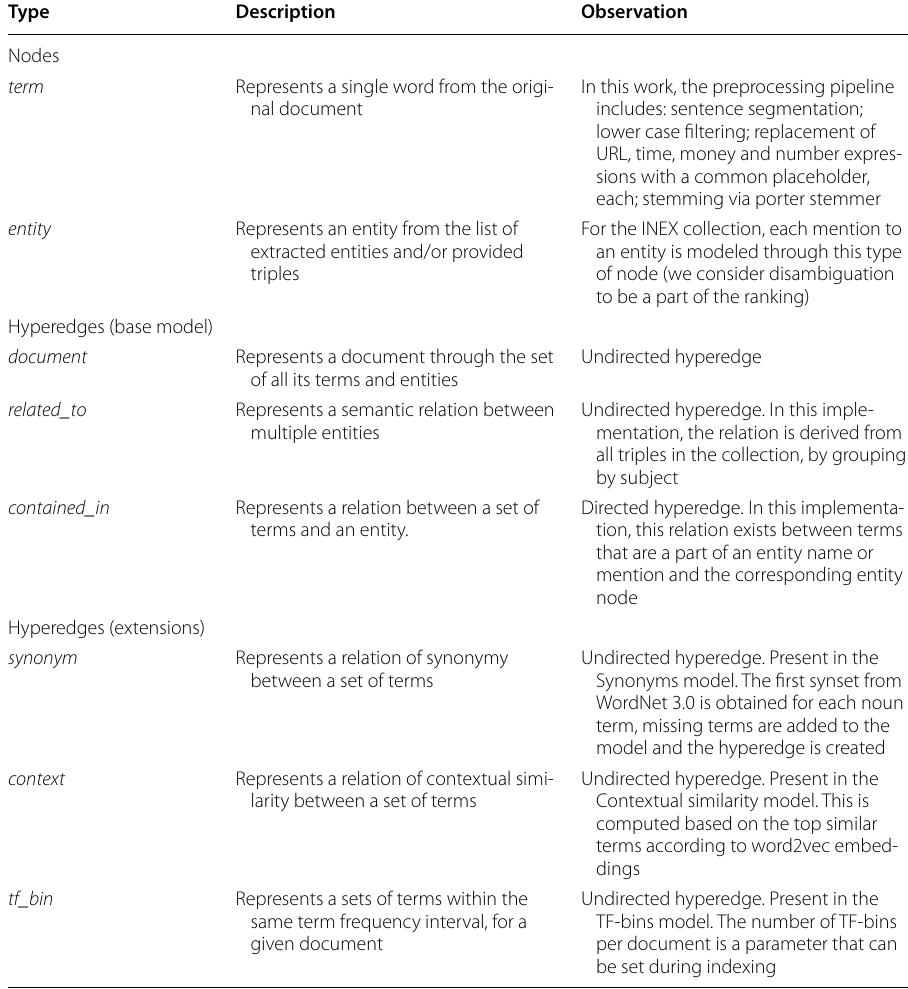
Table 1 Hypergraph-of-entity nodes and